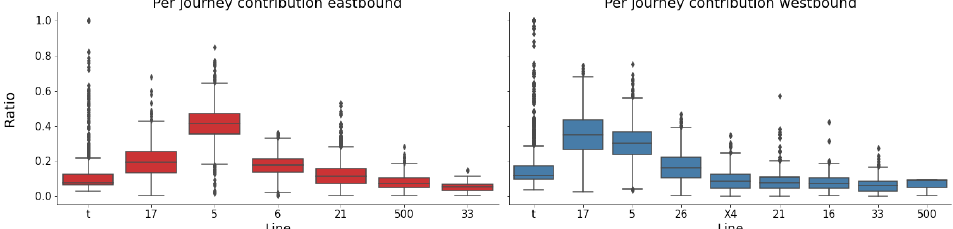
Figure 9. Per journey data composition of 1000 randomly selected